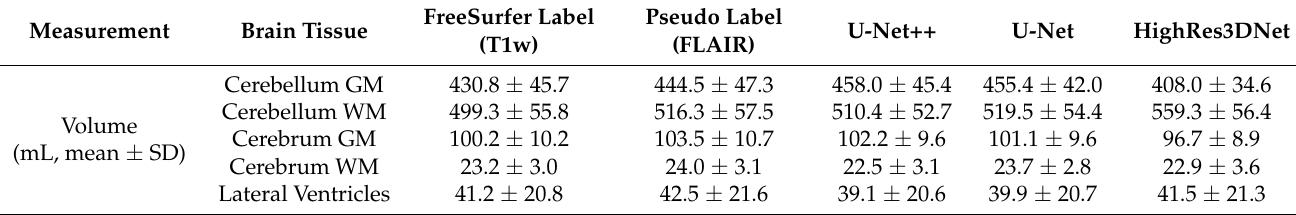
Figure 4. Result of brain tissue segmentation of the same subject in the axial view. The red, green, and blue labels represent the gray matter, white matter, and ventricle regions. Moreover, the highlighted boxes show the differences in the segmentation labels for each model. Table 2. Volume of individual brain tissue from the FreeSurfer labels (T1w MRI), pseudo-labels, U-Net++, U-Net, and HighRes3DNet.